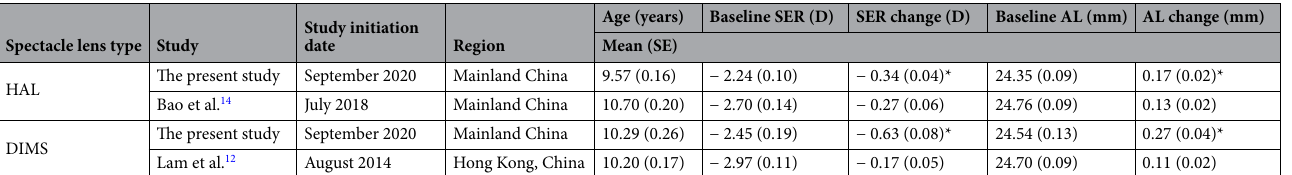
Table 3. Characteristics and unadjusted 1-year outcomes of the subjects in different studies. AL axial length, D diopters, DIMS defocus incorporated multiple segments, HAL highly aspherical lenslets, SE standard error, SER spherical equivalent refraction. *Standardized 1-year